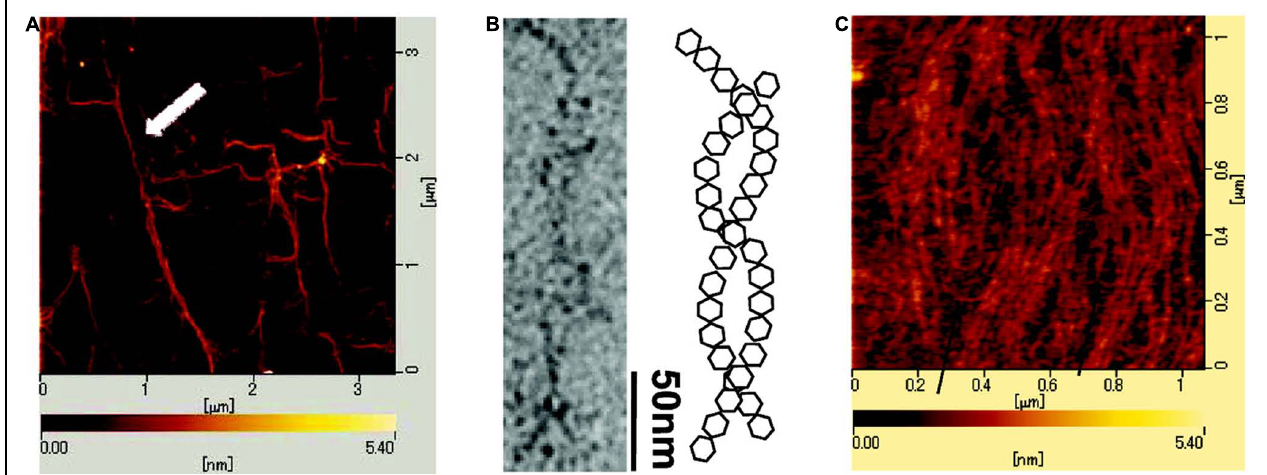
FIGURE 1 | Atomic force (A,C) and electron microscopic (B) images of cyanobacterial polysacaccharide sacran. The atomic force microcsopy (AFM) topograph (A) was obtained from a 1 ppm sacran aqueous aliquot dried on mica. The white arrow highlights a bundle of sacran chains. (B) Transmisssion electron micrograph of sacran dried on carbon-coated Cu-grid and schematic illustration of intertwined (helical)